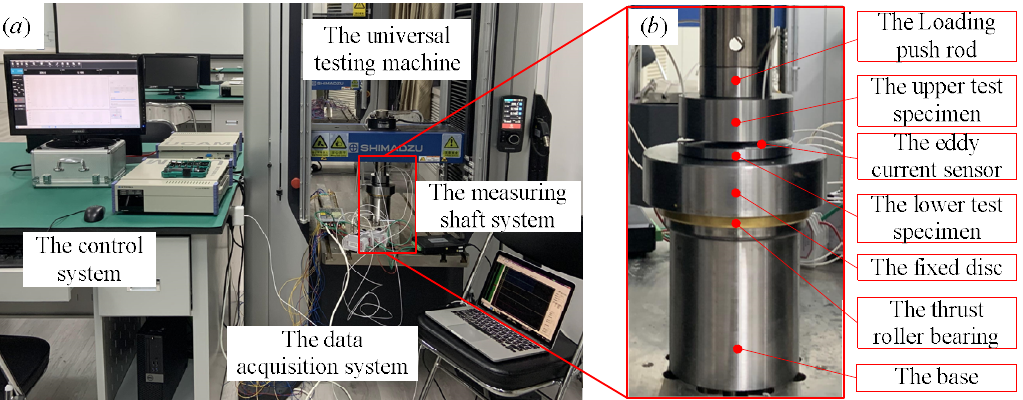
Figure 7. The experimental device: ( a ) the whole set of devices; ( b ) the measuring shaft system.